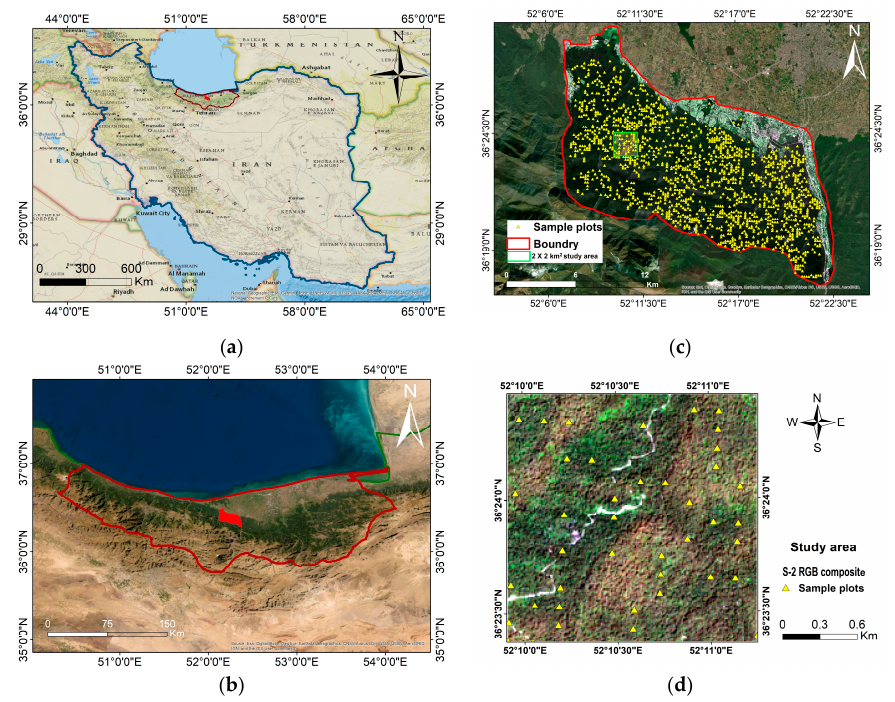
Figure 1. General location of the study area: ( a ) Iran; ( b ) location map; ( c ) The Hyrcanian forests including sample plots; ( d ) Sentinel-2 images (Red Green Blue (RGB) bands).